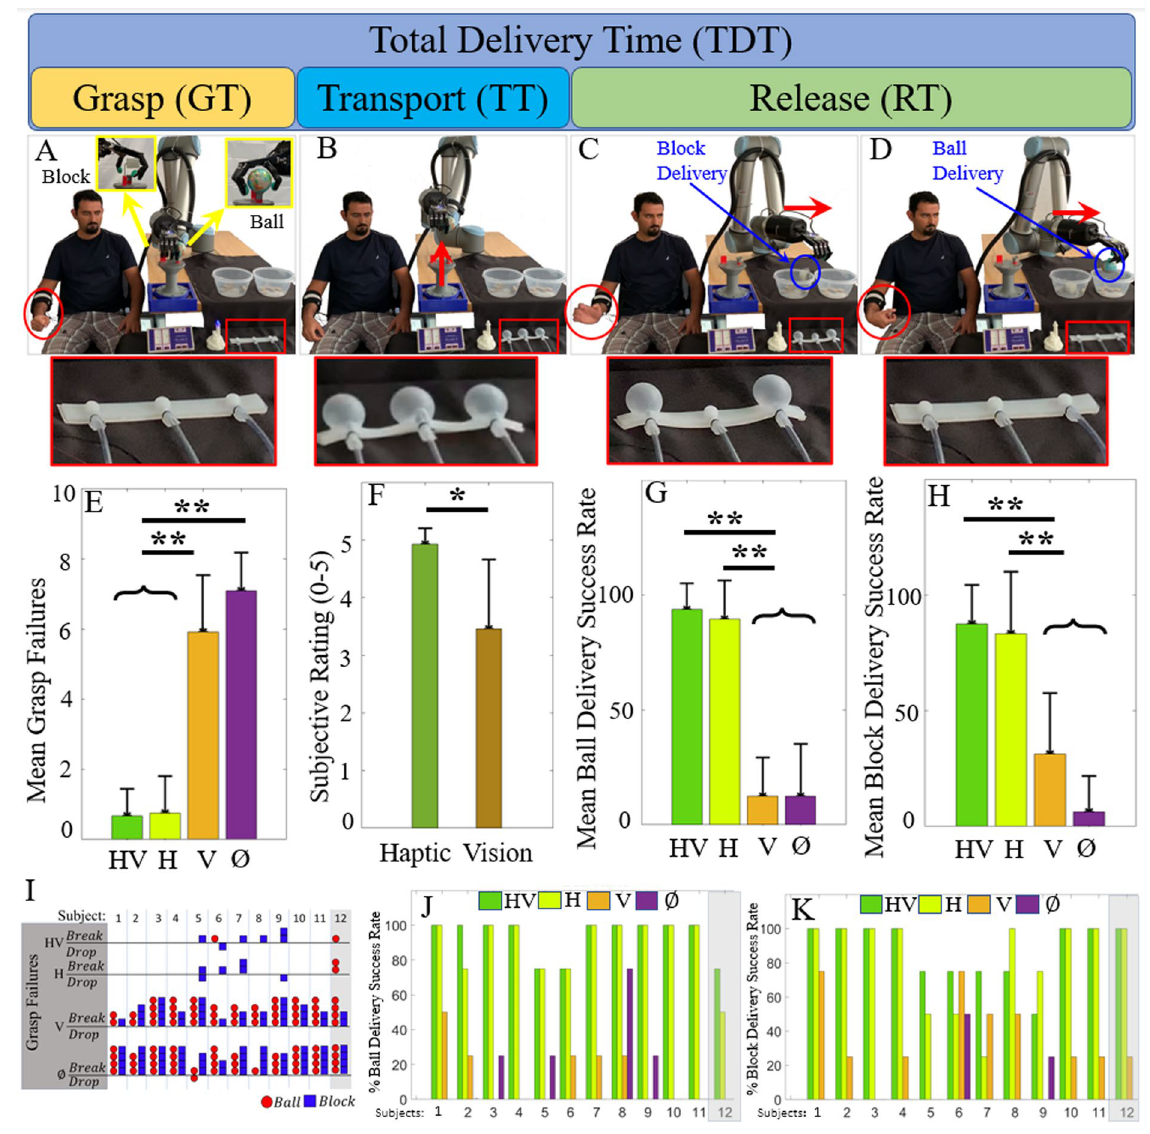
Figure 2. Simultaneous grasp force control overview of success and failure rates. ( A–D ) show consecutive frames of task progression from the simultaneous grasp of both objects ( A ), their concurrent transport ( B ) and deliveries ( C,D ), with an enlarged inset of the soft robotic armband below. Haptic feedback conditions (HV with vision and H without) greatly reduced grasp failure ( E ) when compared to vision alone (V) or no feedback ( ∅ ), and increased successful delivery of both objects ( G,H ), leading subjects to report the haptic feedback as more helpful than visual ( F ). Analysis of grasp failure especially showed a more precise use of robotic forces, specifically leading to a striking reduction in object breakage ( I ). Individual subject’s delivery success rates are provided in ( J,K ). The grey highlight indicates the congenital hand-absent subject 12. There was no statistically significant difference among the subjects. *p < 0.05, **p <